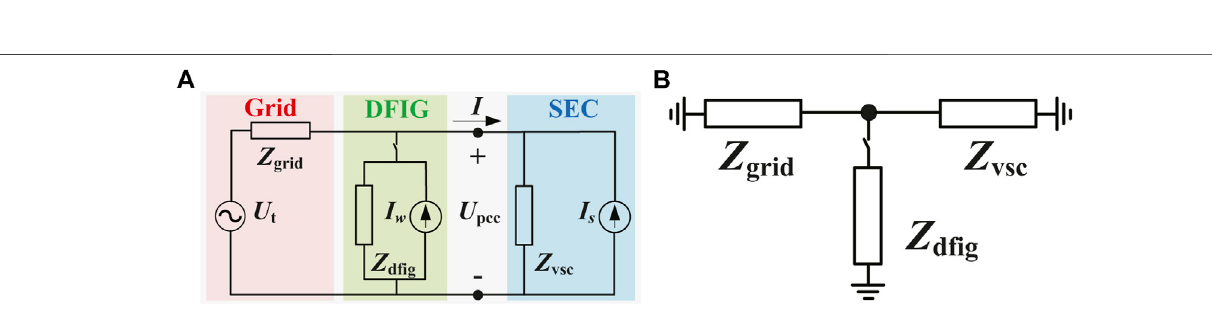
Frontiers in Energy Research |